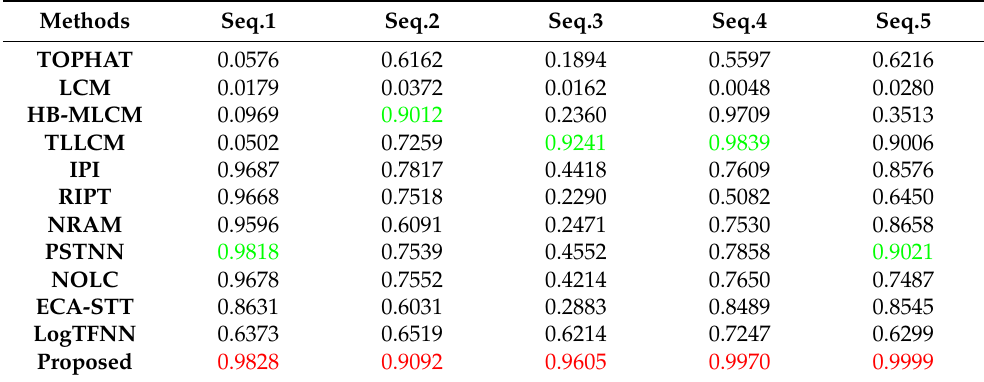
Figure 27. ROC curves of the compared and proposed methods in different sequences. Table 6. AUC of different